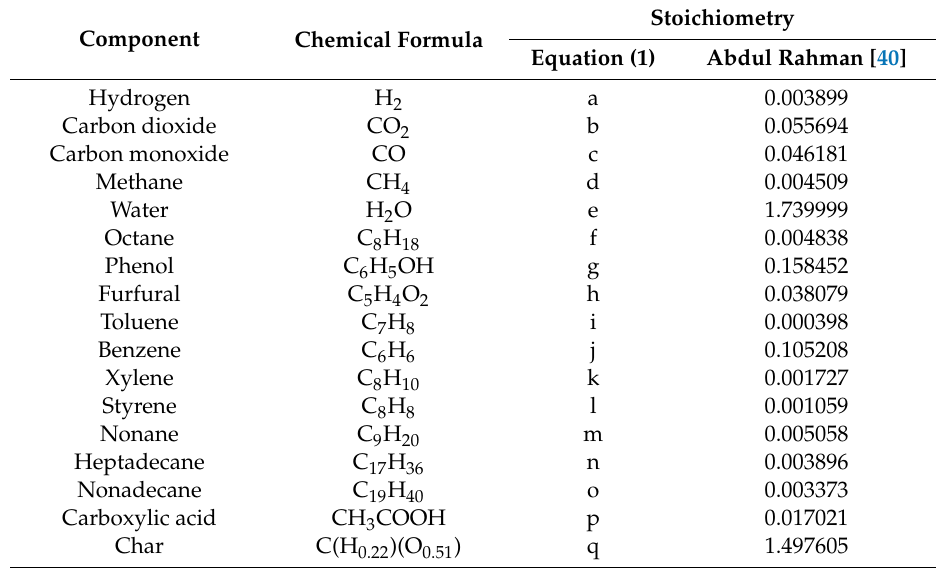
Table 7. The optimum stoichiometric numbers for the pyrolysis of palm kernel cake from the work of Abdul Rahman (2016) [40].